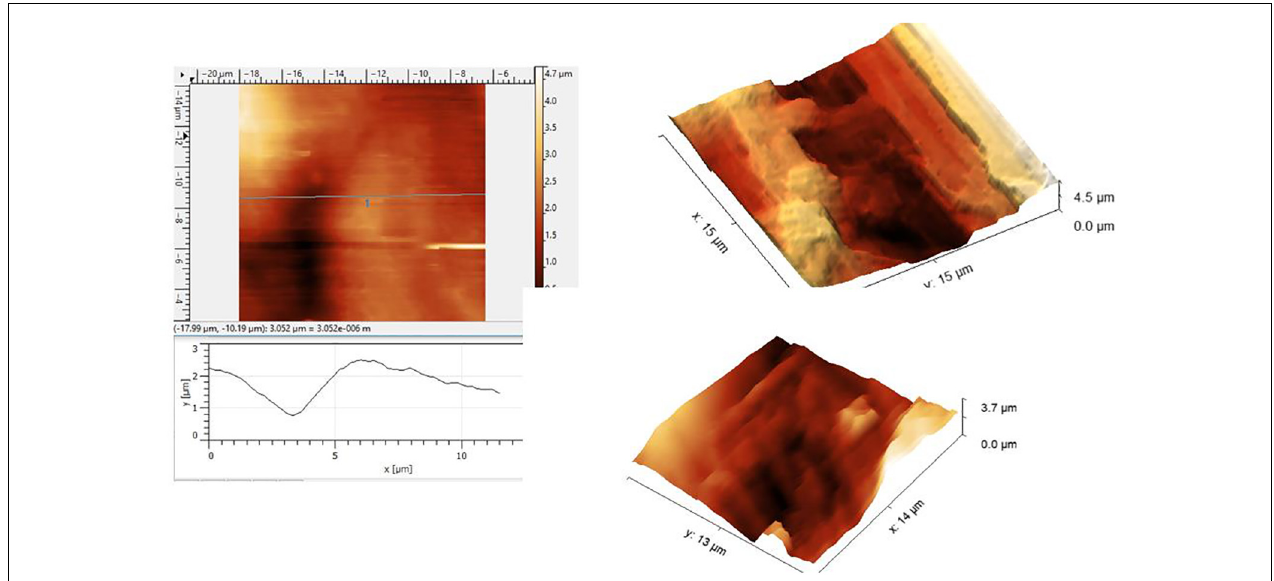
FIGURE 1 | Atomic force microscopy (AFM) scans under the saline of the luminal aspect of the blood vessels at the active hydrophobic spot (AHS) sites. Rough surface disables a closer approach to the sensing probe.